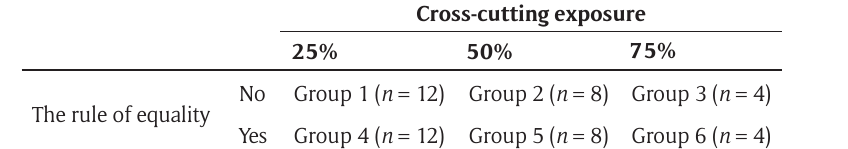
Table 2: The reconstructed experimental setting ( N = 48).